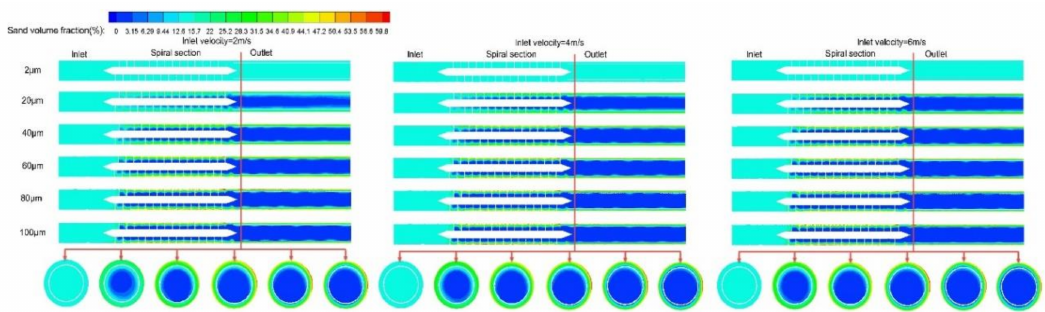
Figure 8. Sand distribution contours across the horizontal section of the spiral separator and the vertical section at the outlet with di ff erent particle diameter and inlet velocity.